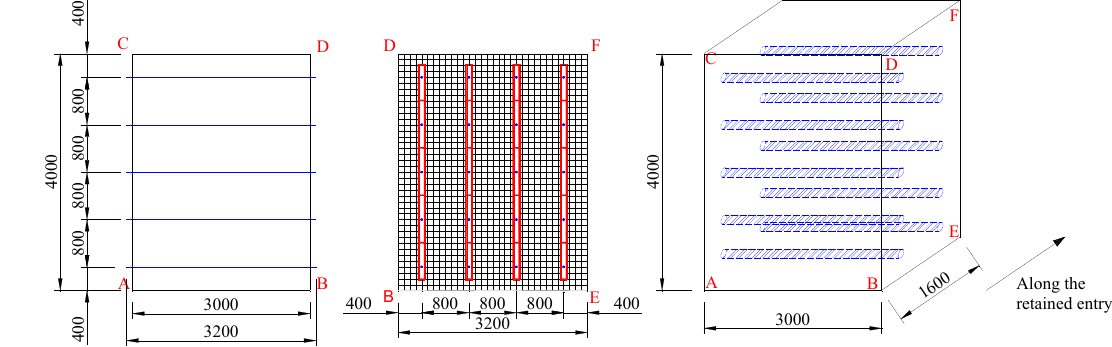
Figure 15. RBB for GER of the 4211 air-return entry (units: mm).